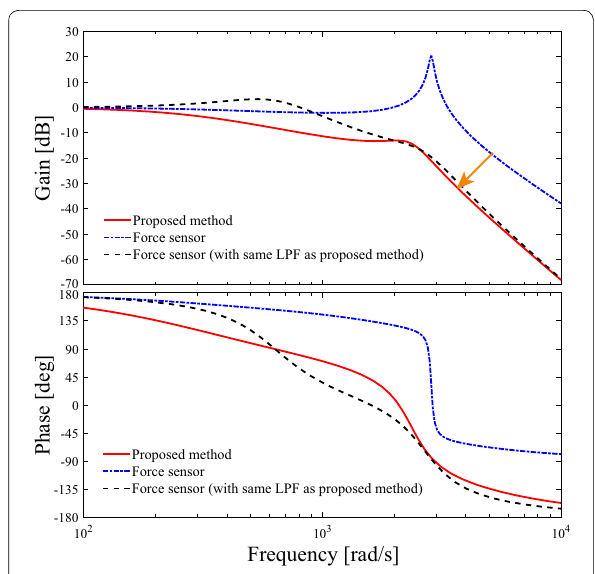
Fig. 8 Bode diagram of the transfer functions from sensor noise to output external